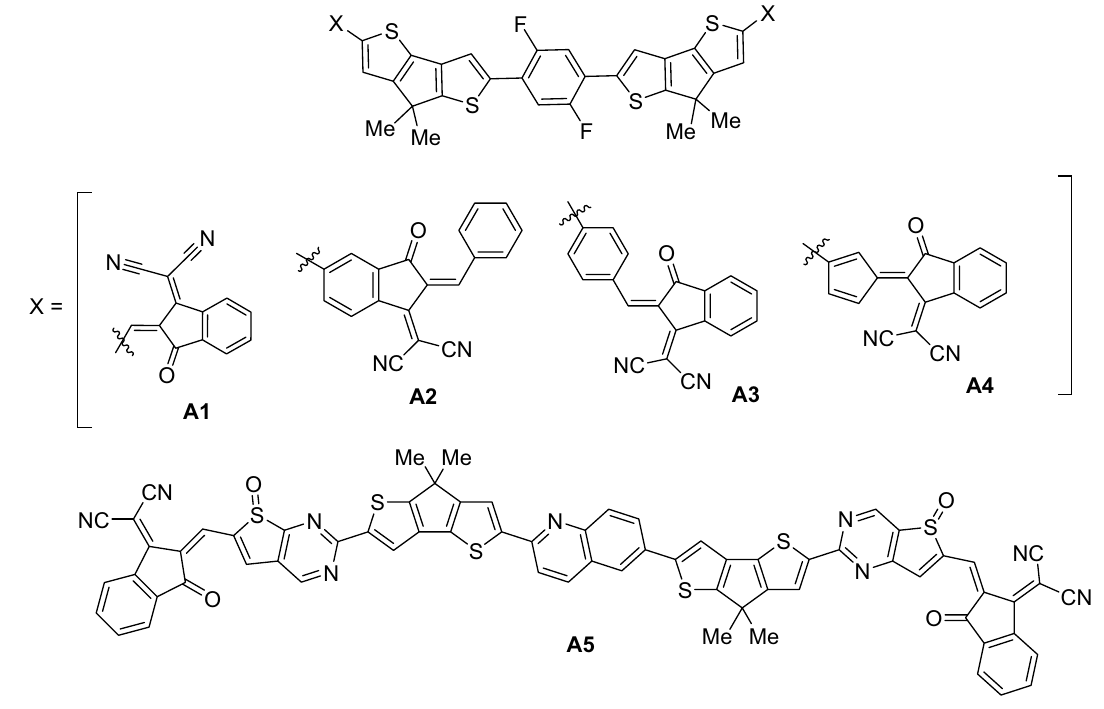
Figure 1. The structure of designed small organic NFA molecules A1 – A5 ; the topmost structure represents core and donor units with X as acceptor unit ( A1–A4 ), the lowest A5 has core, donor and acceptor